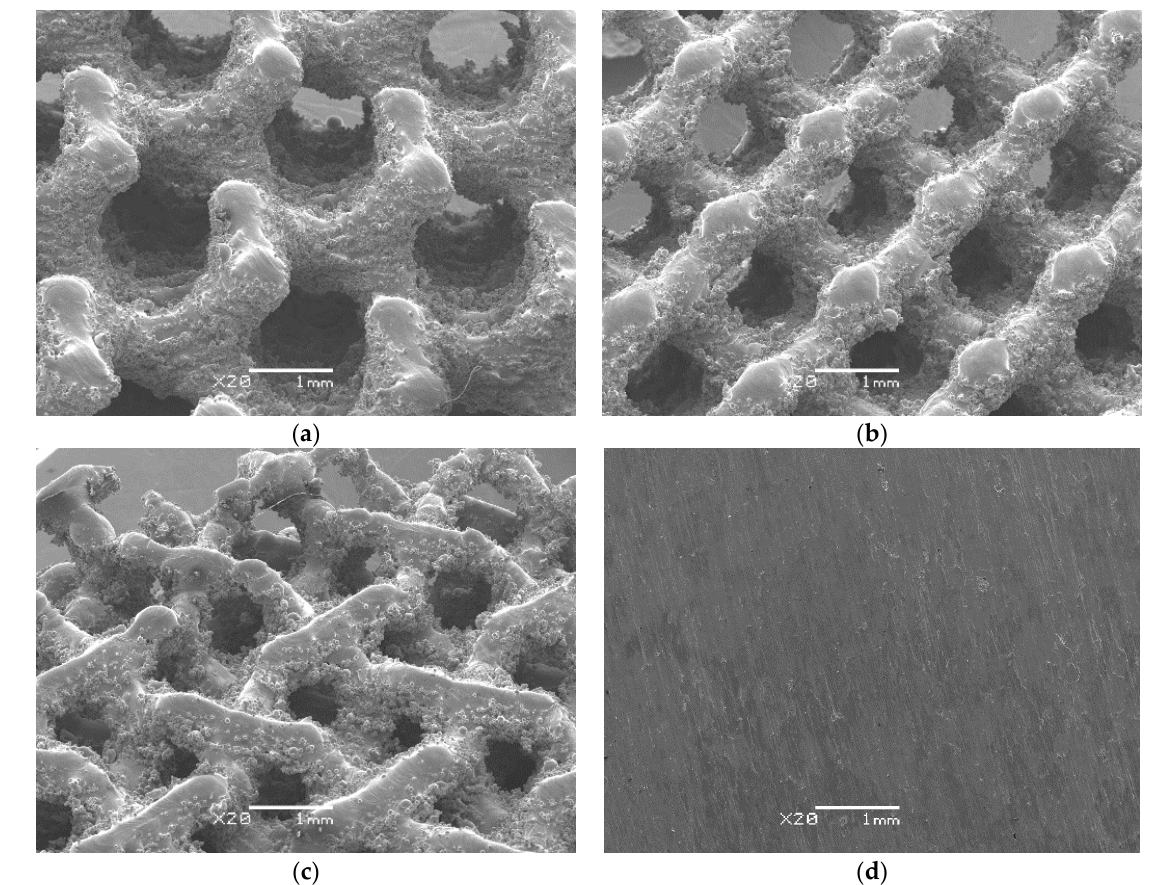
Figure 5. SEM image of surface morphology of the CpTi G2 produced by SLM: ( a ) G80 cellular lattice; ( b ) D80 cellular lattice; ( c ); I-2Y80 cellular lattice; ( d ) Bulk.